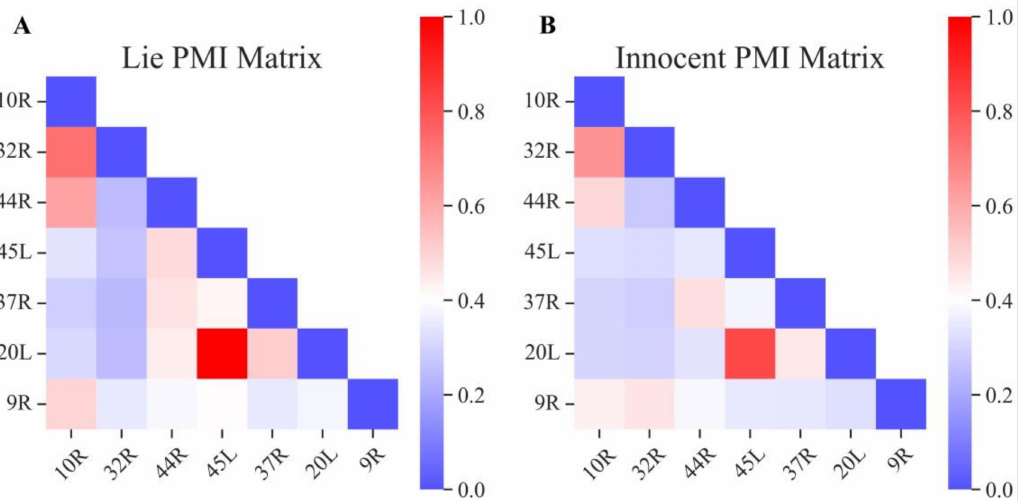
Figure 3. ( A ) The average PMI adjacency matrix of the lying group. ( B ) The average PMI adjacency matrix of the innocent group. The diagonal is conventionally set to 0 for all nodes. Only the lower half of the adjacency matrix is shown, which is due to PMI’s